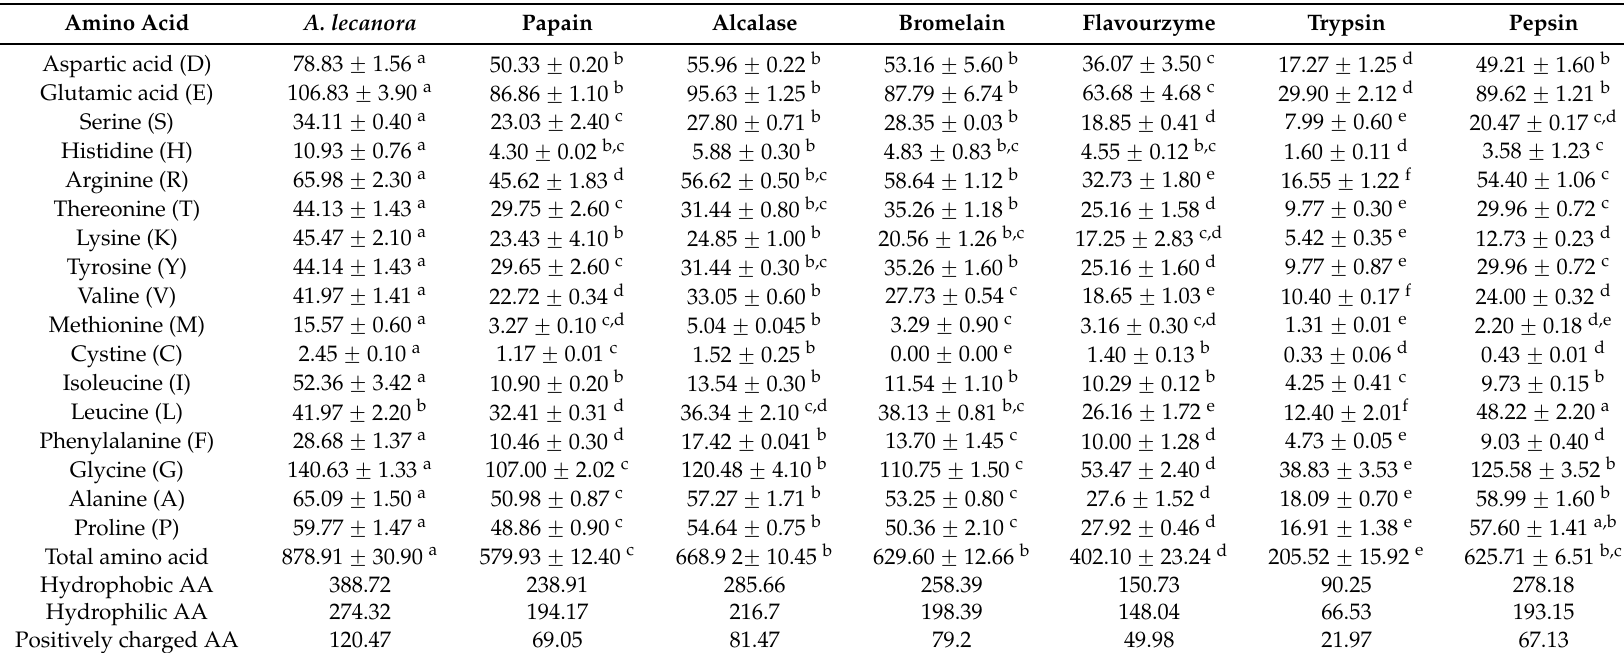
Table 2. Amino acid composition (mg/g dry weight) of freeze dried A. lecanora and A. lecanora hydrolysates after 24 h of hydrolysis